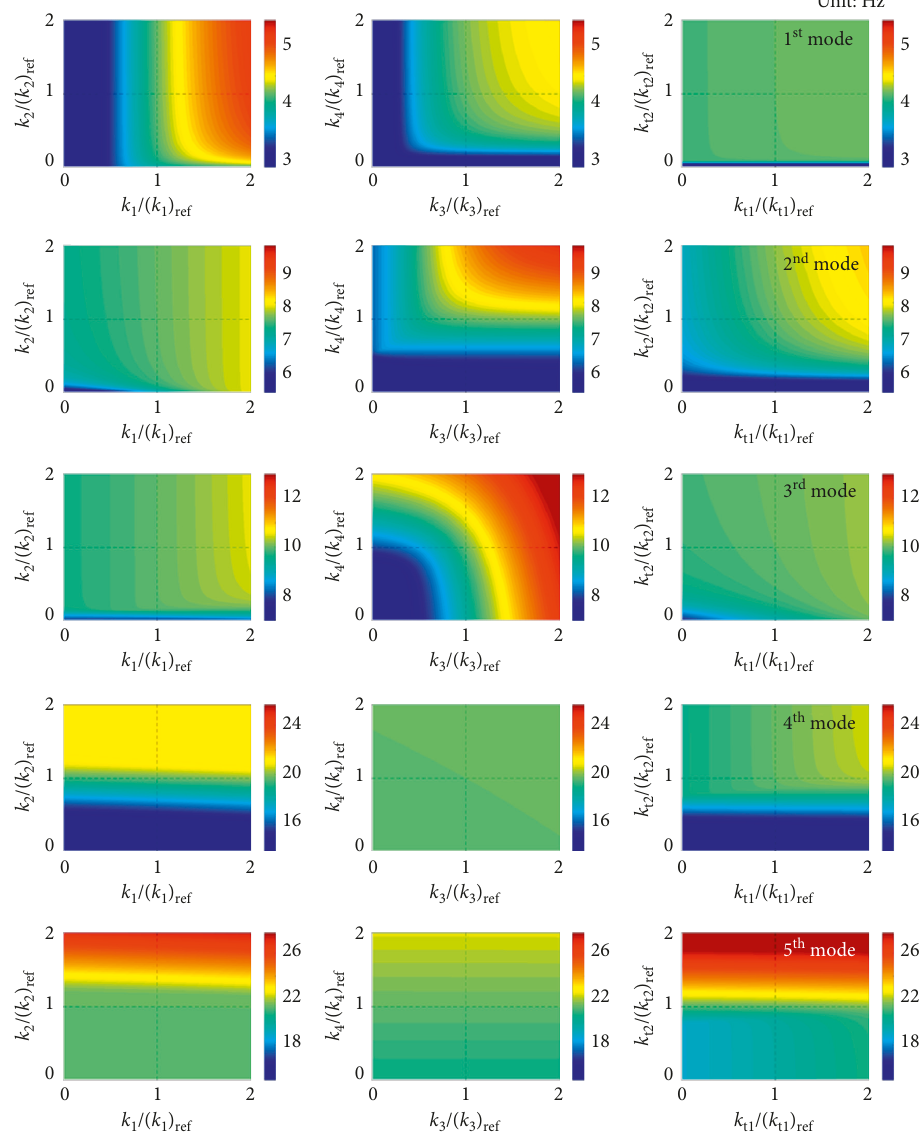
Figure 6: Natural frequency of the human model with respect to the translational and torsional stiffness values (dotted black vertical and horizontal line: baseline values of the stiffness; the top through the bottom rows, respectively, represent the first through the fifth